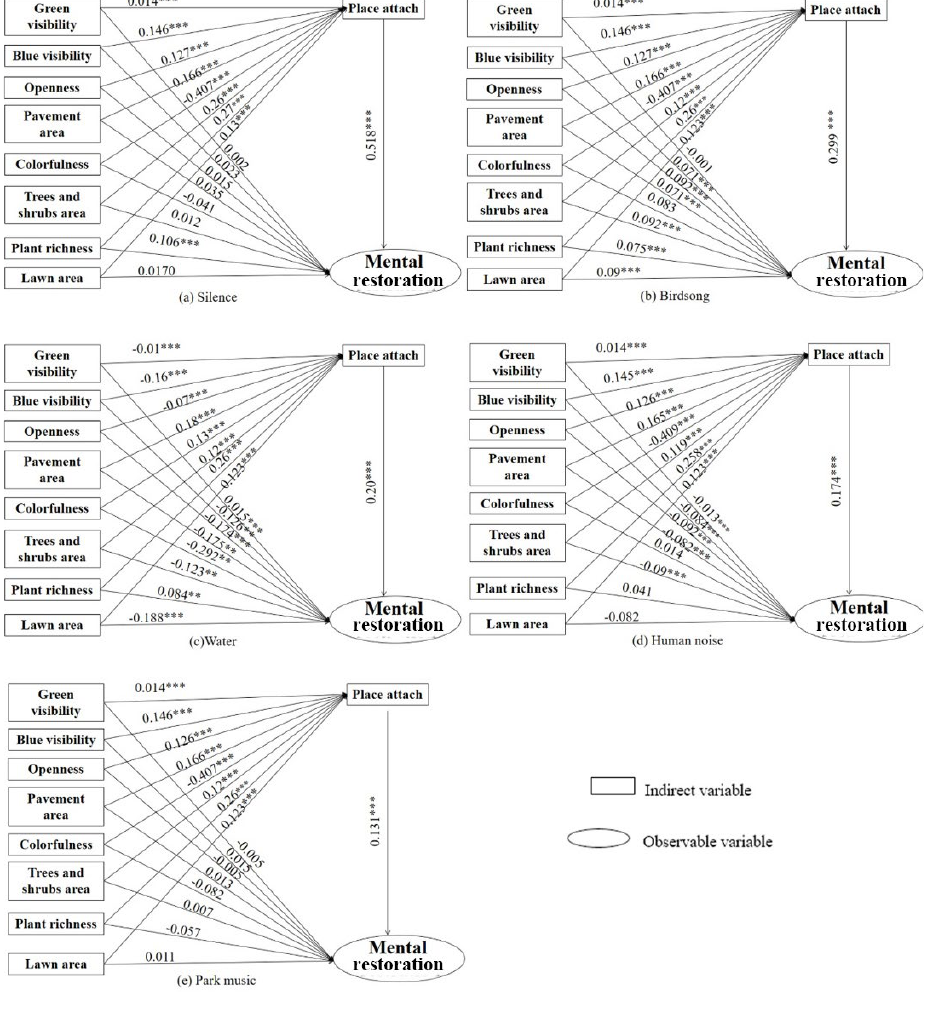
Figure 7. Standardized path coefficients of the SEM (( a ) is the result of the structural equation model